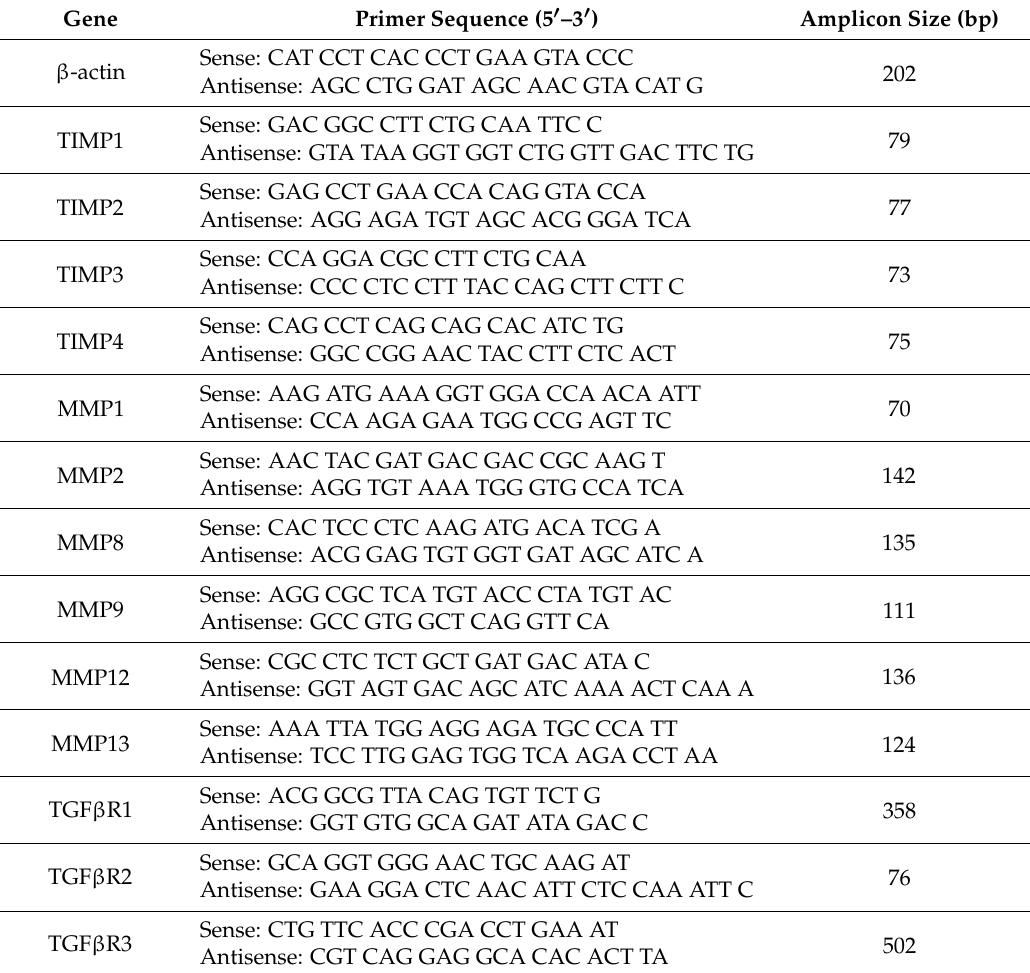
Table 3. Oligonucleotide sequences and amplicon sizes in conventional and quantitative real-time PCR. bp: base pairs.